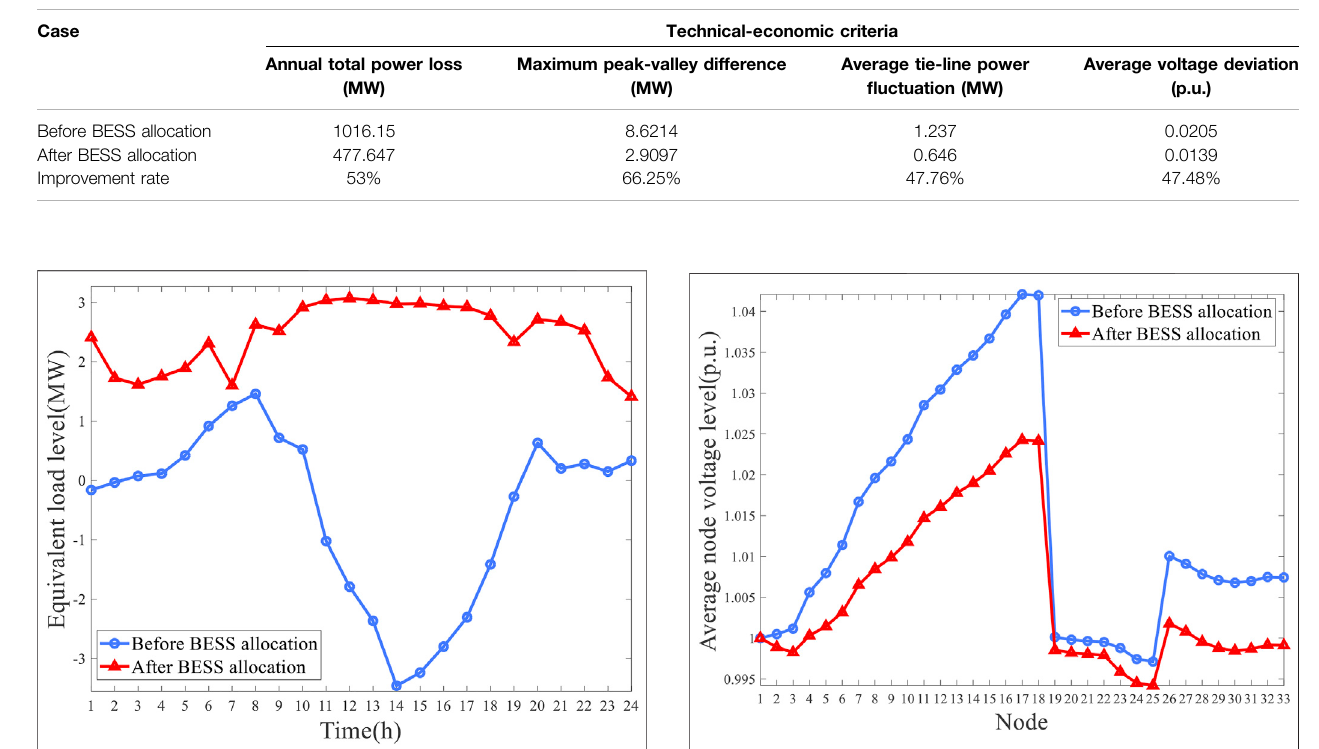
TABLE 4 | Optimization results of DN via the BESS.